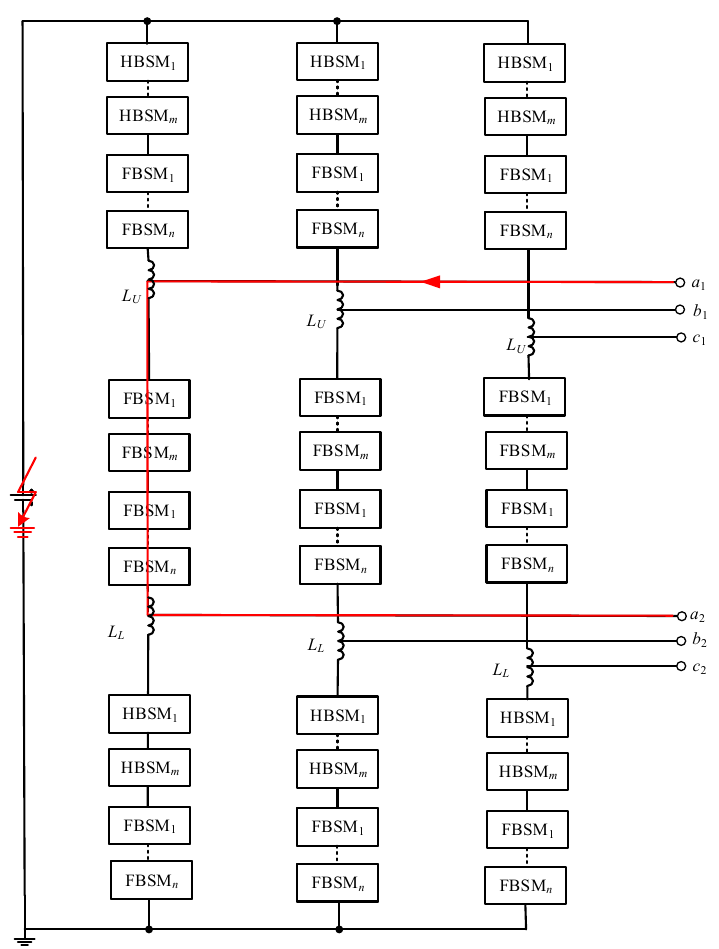
Figure 7. Potential flow path of short-circuit current ( a 1 – middle arm – a 2